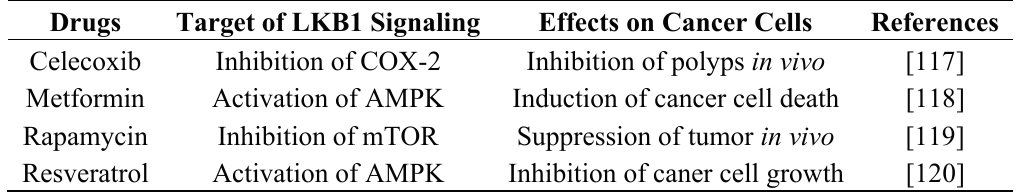
Table 2. Representative agents targeting LKB1 signaling associated with cancer